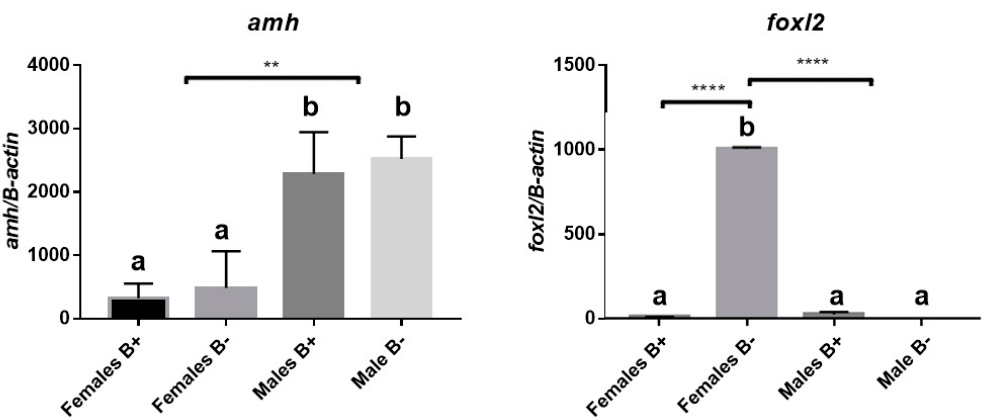
Figure 2. Relative expression levels of amh and foxl2a of adult A. scabripinnis . Groups that are significantly di ff erent from each other are represented by di ff erent letters (a and b). (B + ) individuals with and (B − ) without the B chromosome, respectively. **** p < 0.0001, extremely significant; ** p 0.001 to 0.01, very significant.